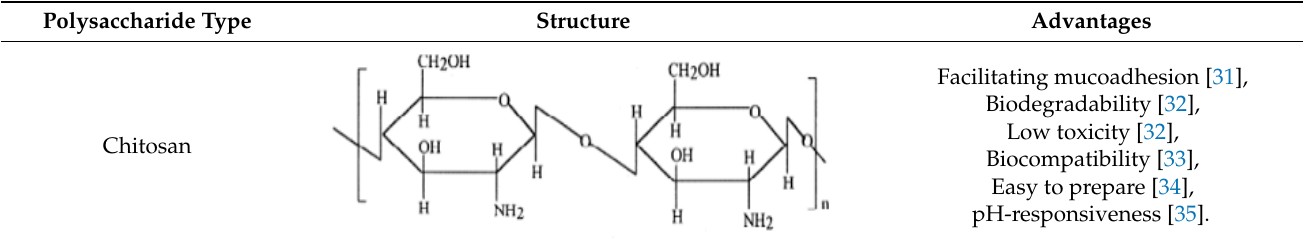
Table 1. Nano-based lung cancer treatment using polysaccharides: structure and benefits.